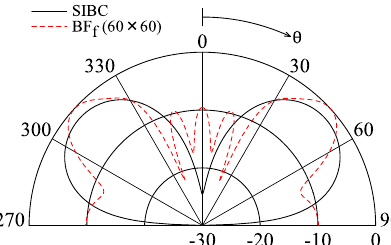
Fig. 13. Radiation patterns of half-wavelength dipole antenna calculated by BF f -FDTD